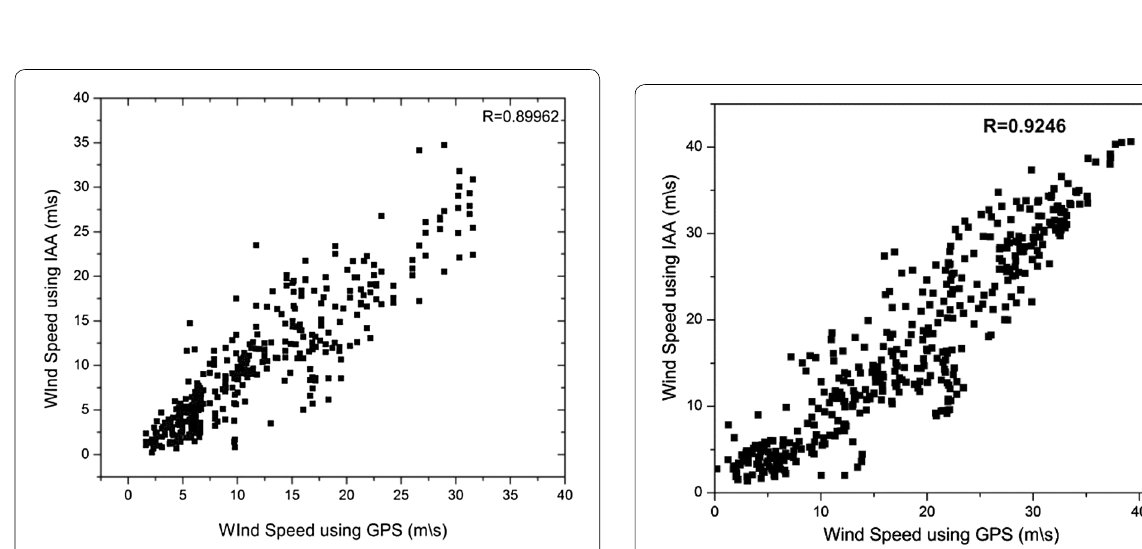
Fig. 9 Correlation between IAA and GPS wind speeds for data during 4th–8th October 2006